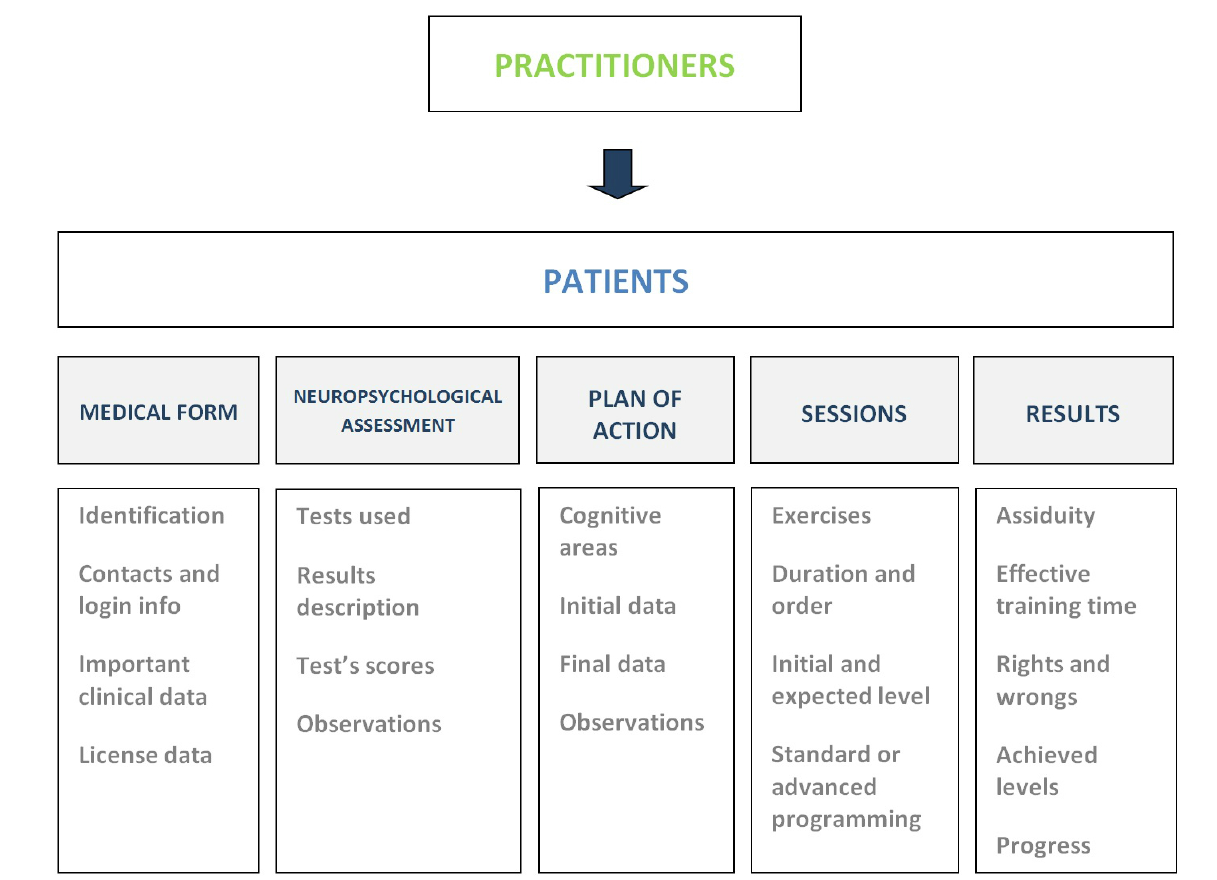
Figure 2. Global system